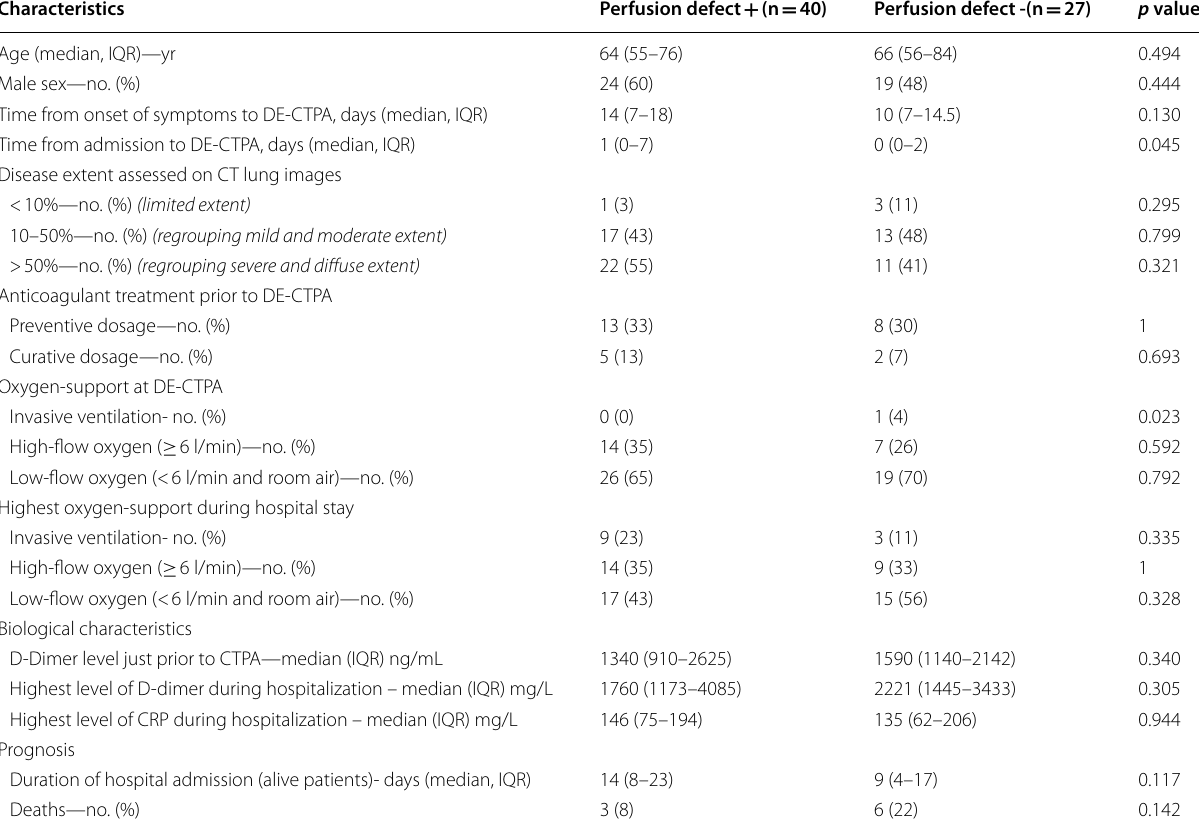
Table 3 Clinical, biological, radiological characteristics and outcome of PD